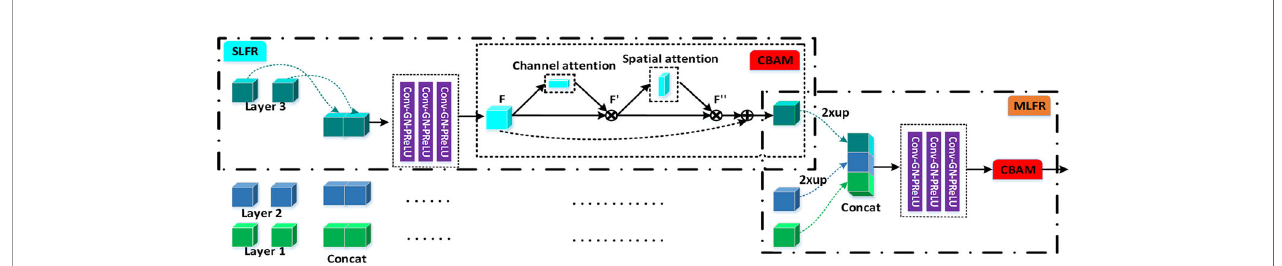
FIGURE 2 | The schematic illustration of the SLFR module and MLFR